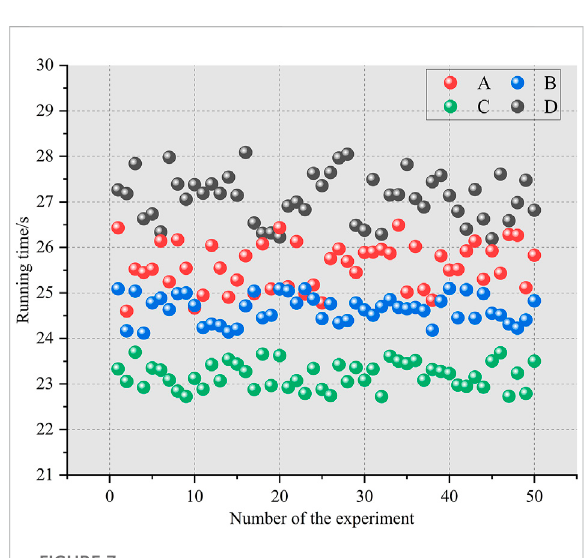
FIGURE 7 Scatter chart of running time of (A) CEEMDAN-CatBoost- SATCN, (B) SATCN, (C) CatBoost-SATCN, and (D) CEEMDAN- SATCN